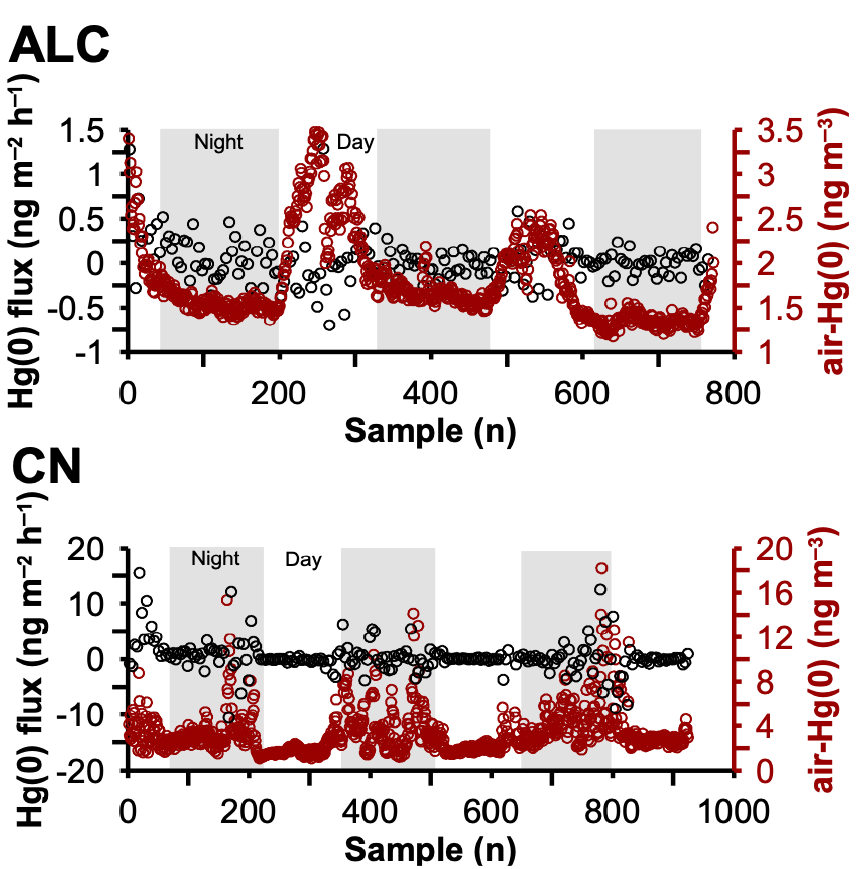
Figure 7. Diurnal variation of air Hg(0) concentrations (ng m −3 ) and vegetation–air Hg(0) fluxes (ng m −2 h −1 ) in vegetated saltmarsh areas from the background site ALC and the industrial site CN. The grey shadow areas correspond to the night period.